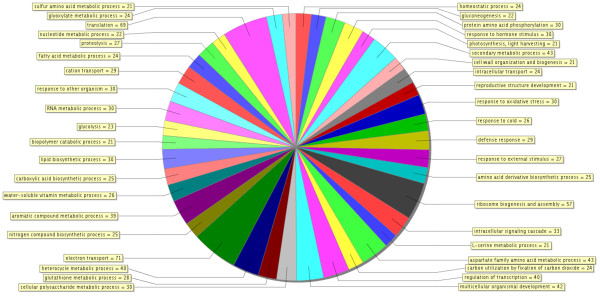
A multilevel pie chart showing the distribution of probes on the chip. Biological processes within all of the lowest nodes with the given number of sequences or score value plot jointly with an e- value cutoff (e-06).